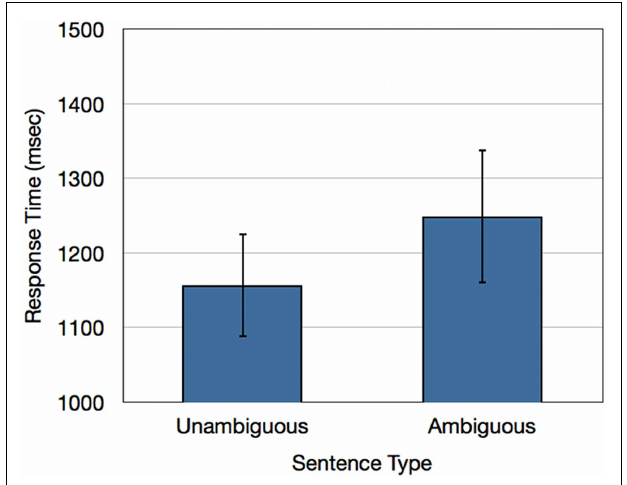
FIGURE 2 | Response times (ms) for healthy young adults for unambiguous baseline sentences and ambiguous doubly-quantified